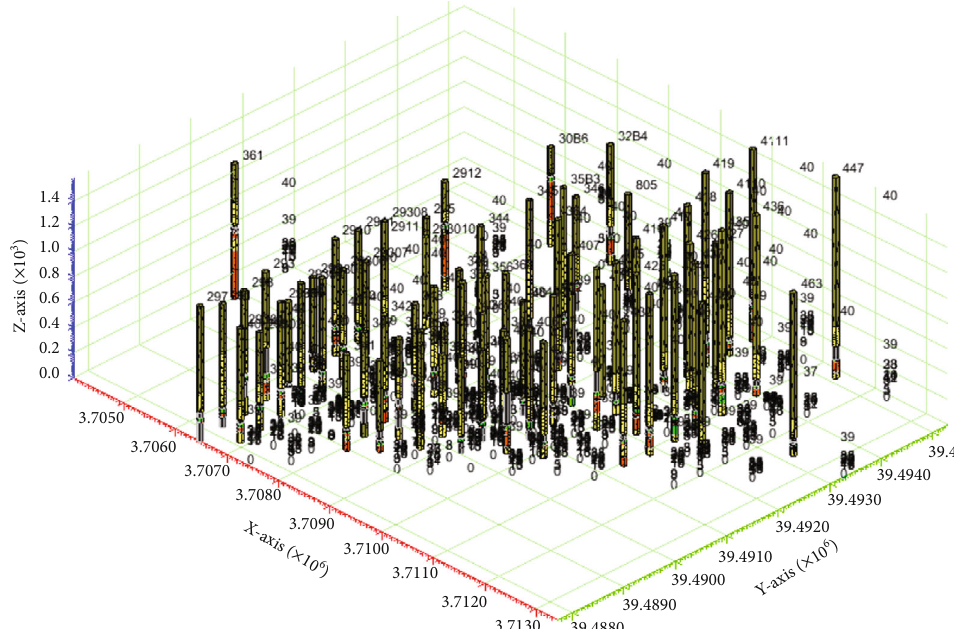
Figure 8: Drill holes of the experimental coal mine for the GMS modeling.